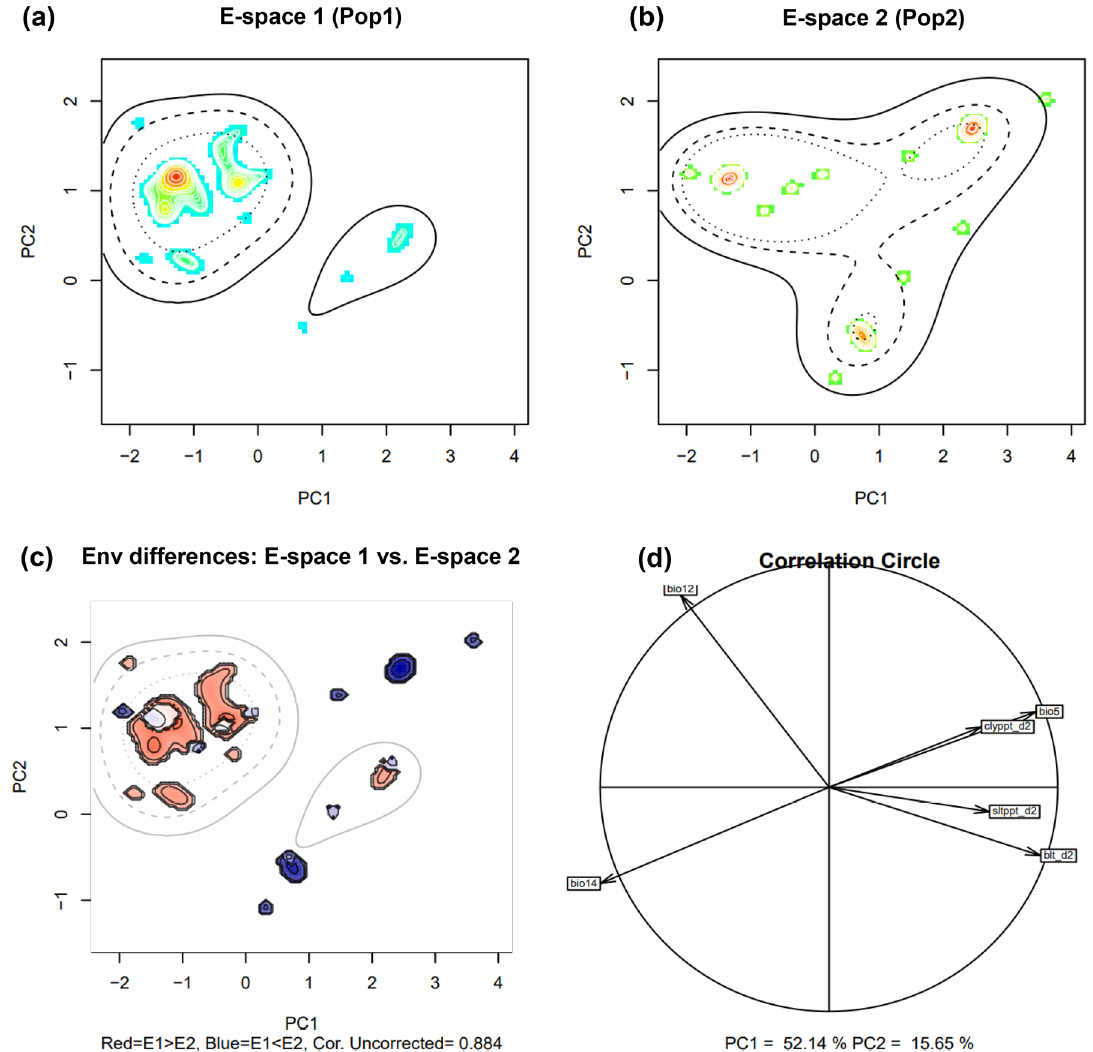
Figure 6. Niches of the two genetic populations in two dimensional E-space. Graphs ( a ) and ( b ) represent the niches of Pop1 and Pop2, respectively along the first two axes of the PCA. The occurrences are represented by kernel density isopleths, red colour indicates high density and blue colour indicates low density. Solid and dotted contour lines illustrate 100% and 50% of the available background (environmental space). ( c ): is the diference in the E-space of the two populations, and Niche E-space Correlation Index (NECI). NECI determines if one should correct the occurrence densities of each population by the prevalence of their environments in their range for equivalency and background tests. For high NECI (> 0.5) genetic populations occupied niches are recommended to be corrected by the frequency of E-space in accessible environments to reduce the chances of committing type 1 errors, and ( d ) is the correlation circle based on the two principal components of the environmental input data. bio5 max temperature warmest month, bio12 mean annual rainfall, bio14 rainfall driest month, blt_d2 bulk density in kg/cubic-meter for 10 cm depth, clyppt_d2 soil texture fraction clay at 10 cm depth, Sltppt_d2 soil texture fraction silt in percent for 10 cm